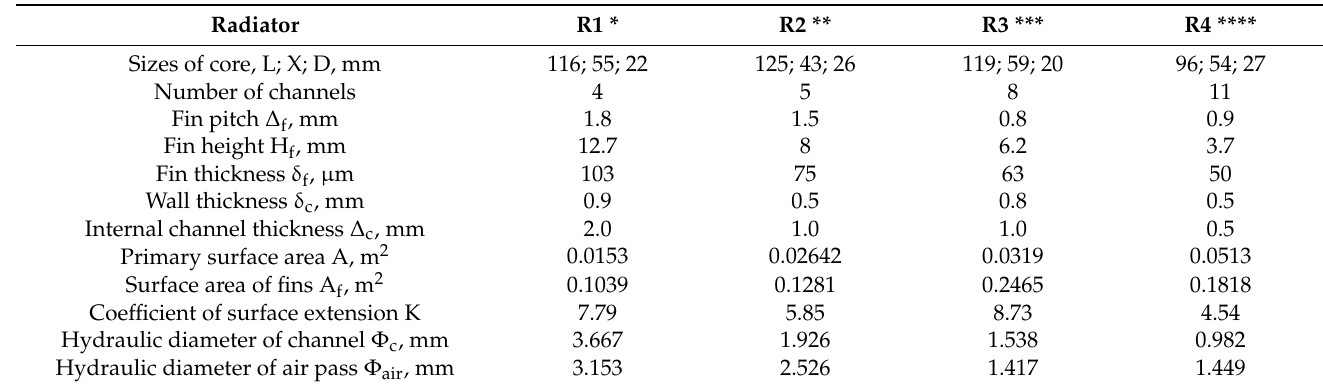
Table 1. Geometry of the tested radiators.